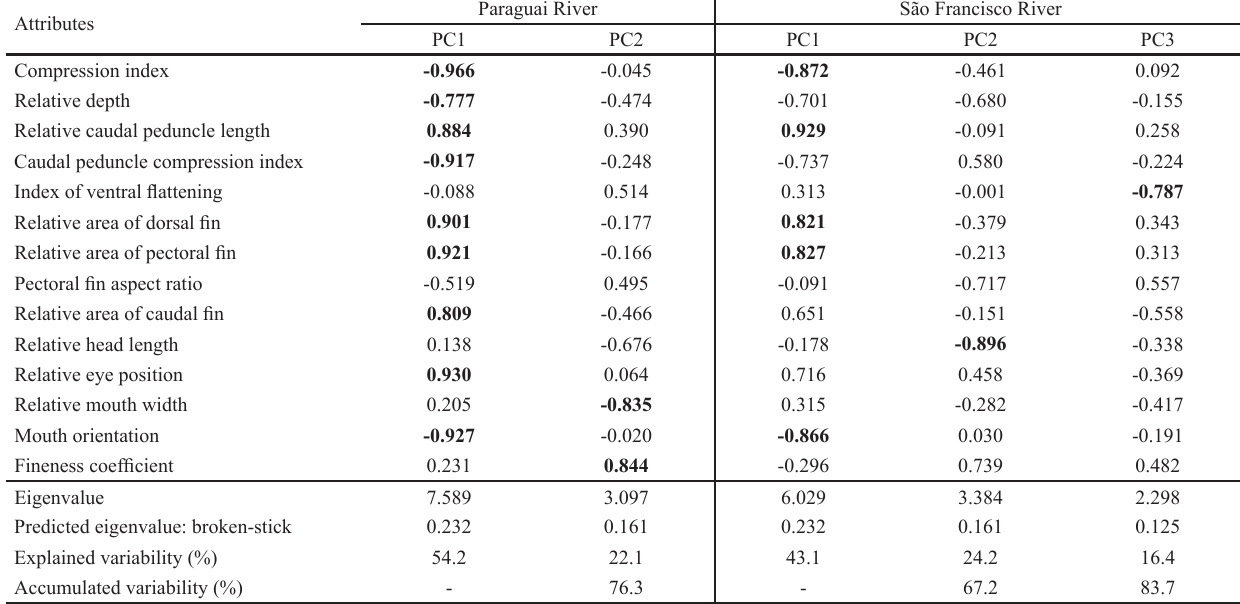
Table 1. Contribution of the 14 ecomorphological attributes for the significant principal component axes, calculated for fish species from the upper Paraguai and upper São Francisco River basins, Brazil. The most important eigenvectors for axes interpretation are in